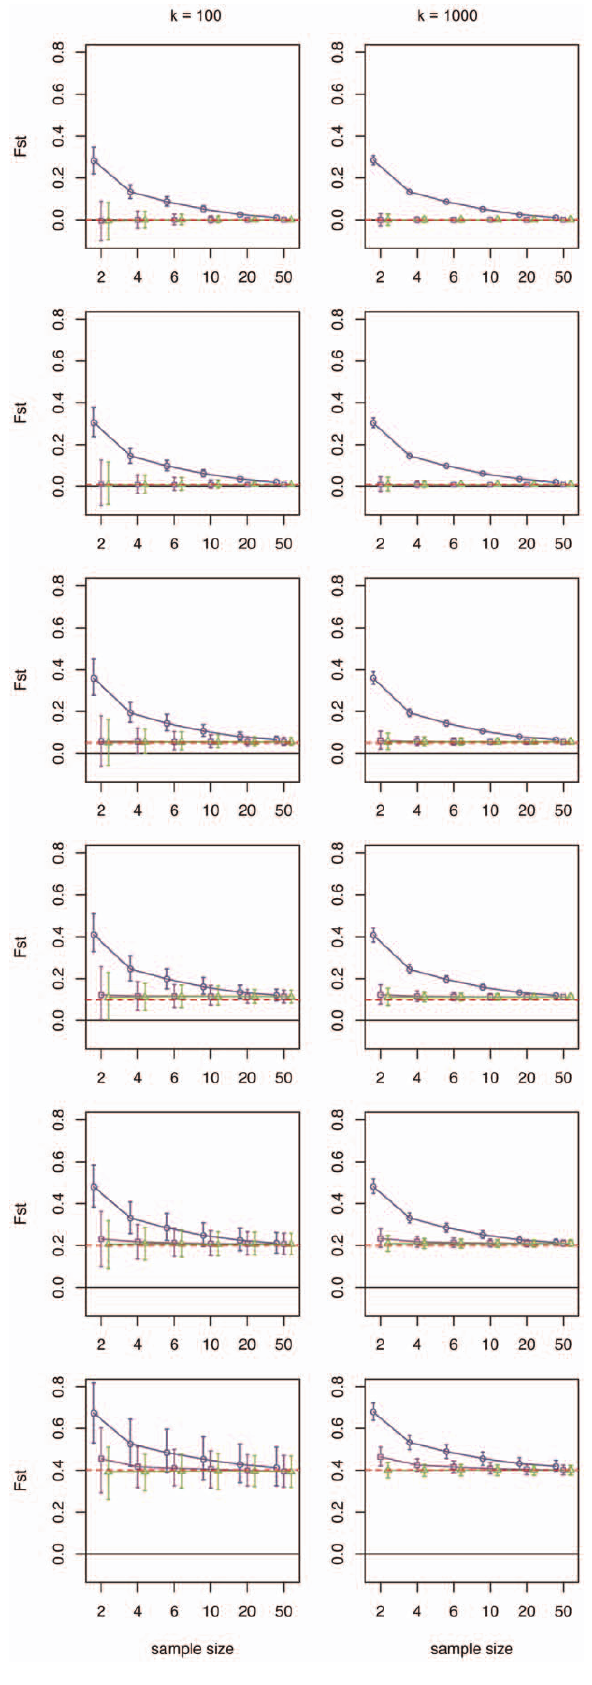
Figure 1. Effect of increasing sample sizes. Results are shown for the simulations where allele frequencies were equally distributed from 0.05 to 0.95. The number of markers was fixed at k=100 (left column) and k=1,000 (right column). Each row contains a different level of genetic differentiation (F ST =0, 0.01, 0.05, 0.1, 0.2, 0.4). The results (average F ST and 95% CI) of each estimator are depicted in the different graphs: F STW (blue circles), F STC&W (purple squares) and F STR (green triangles). The dashed red line indicates the actual F ST for the simulated